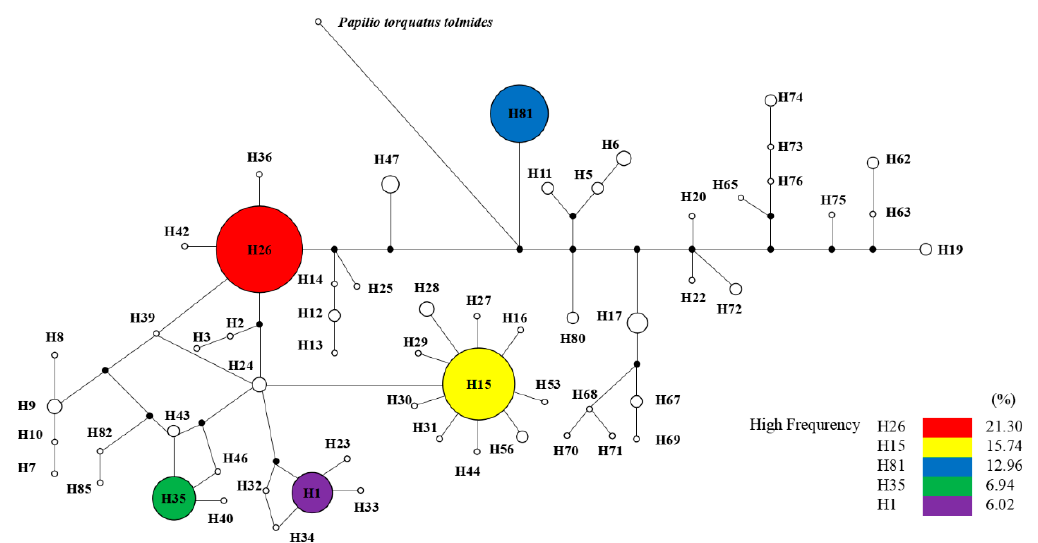
Figure 6. Phylogenetic network of COI gene haplotypes of host insects of O. sinensis . Circle areas are proportional to haplotype frequencies. Papilio torquatus tolmides (GenBank accession No. JQ606303.1) was an outgroup.